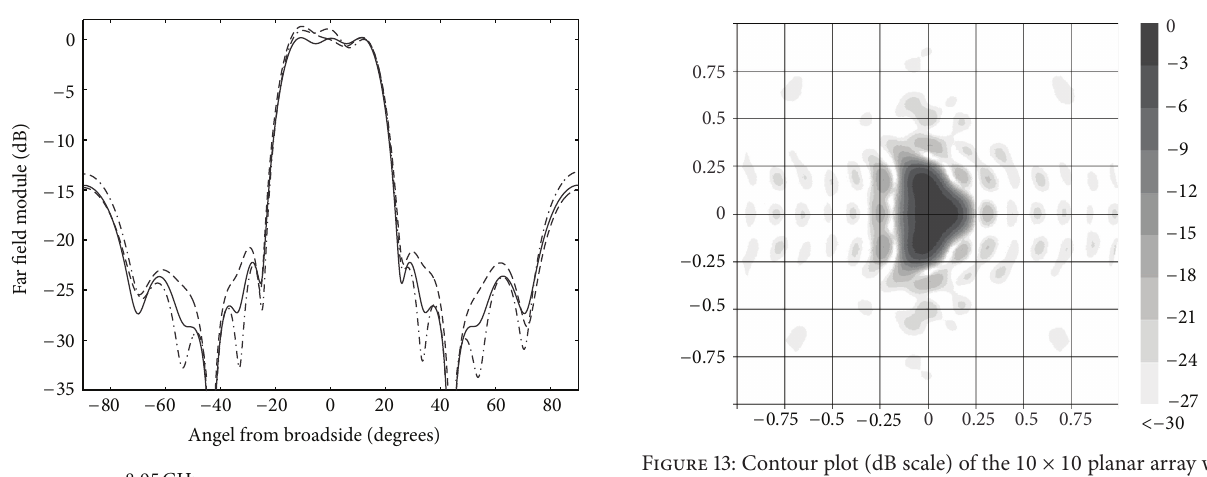
Figure 13: Contour plot (dB scale) of the 10 × 10 planar array with an arrow-shaped radiation pattern in the u - v plane.